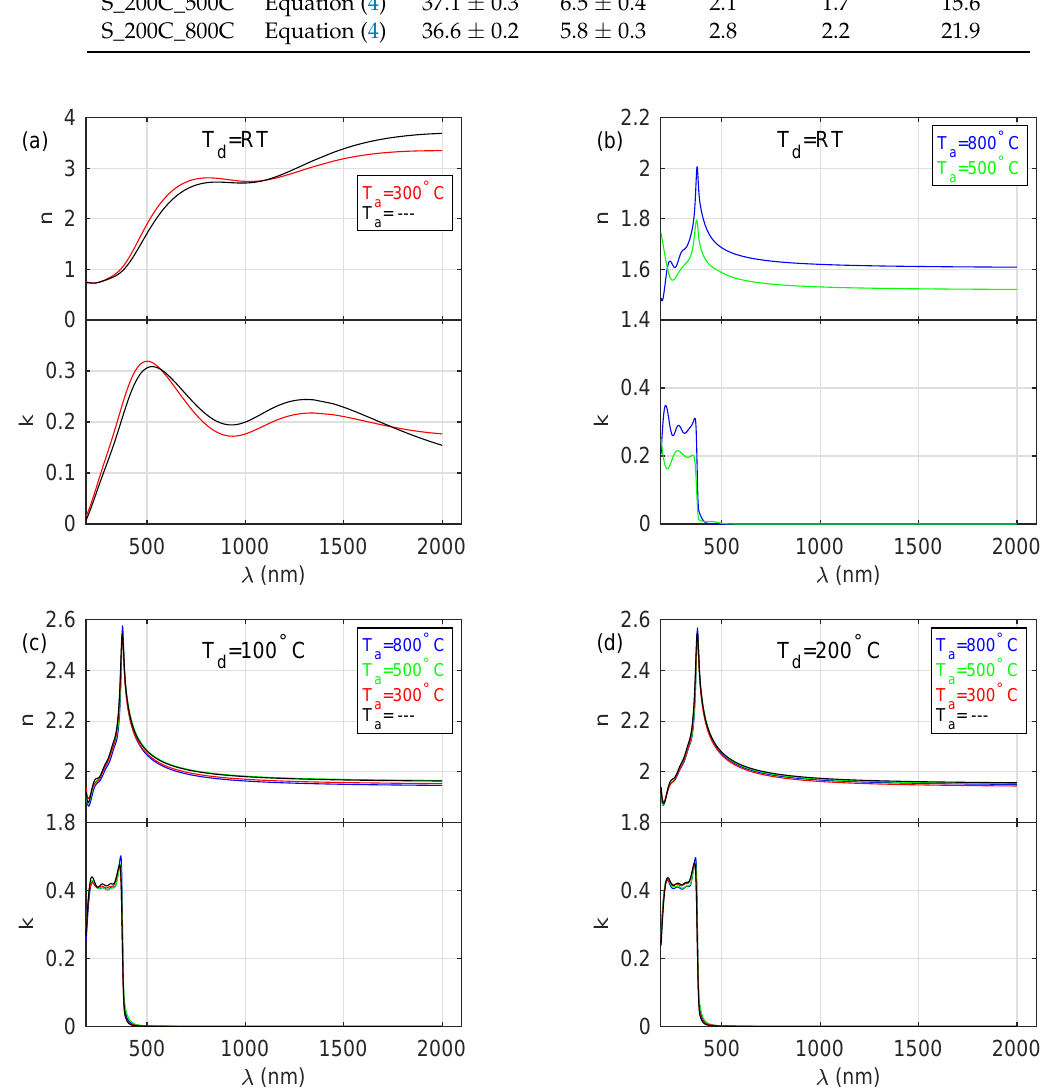
Figure 2. The index of refraction ( n ) and the extinction coefficient ( k ) for the layers deposited at ( a ) and ( b ) room temperature, ( c ) 100 ◦ C and ( d ) 200 ◦ C and annealed at 300, 500 and 800 ◦